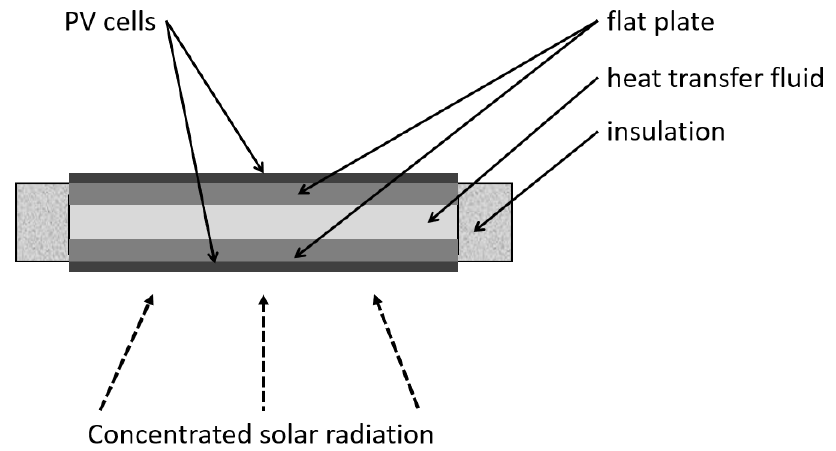
Figure 24. The cross-sectional view of a heat receiver with flow between two flat plates.